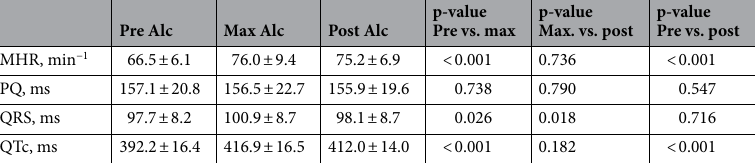
p-value Pre vs. max